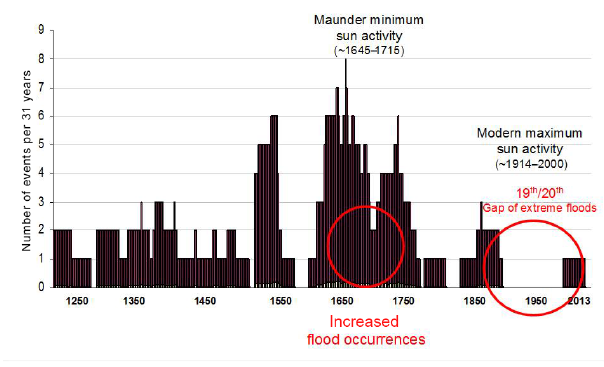
Figure 6. Thirty-one-year running mean of extreme Rhine River flood events ( ≥ 4300m 3 s − 1 ) in Basel.